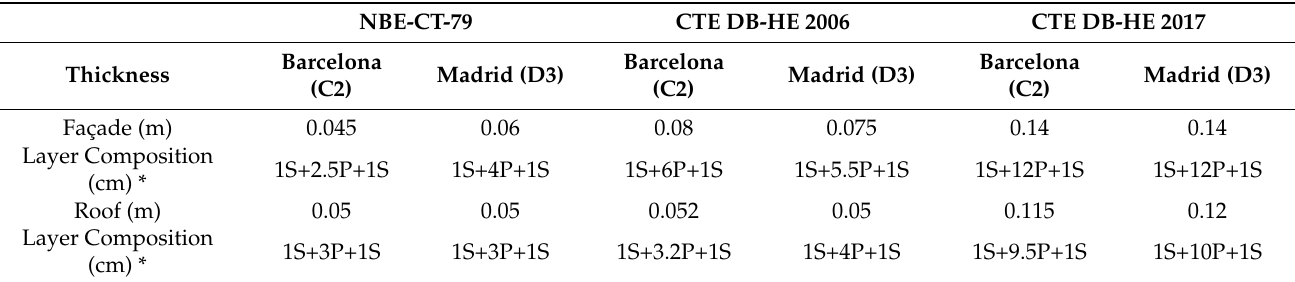
Table 4. Thickness and building components per layer.